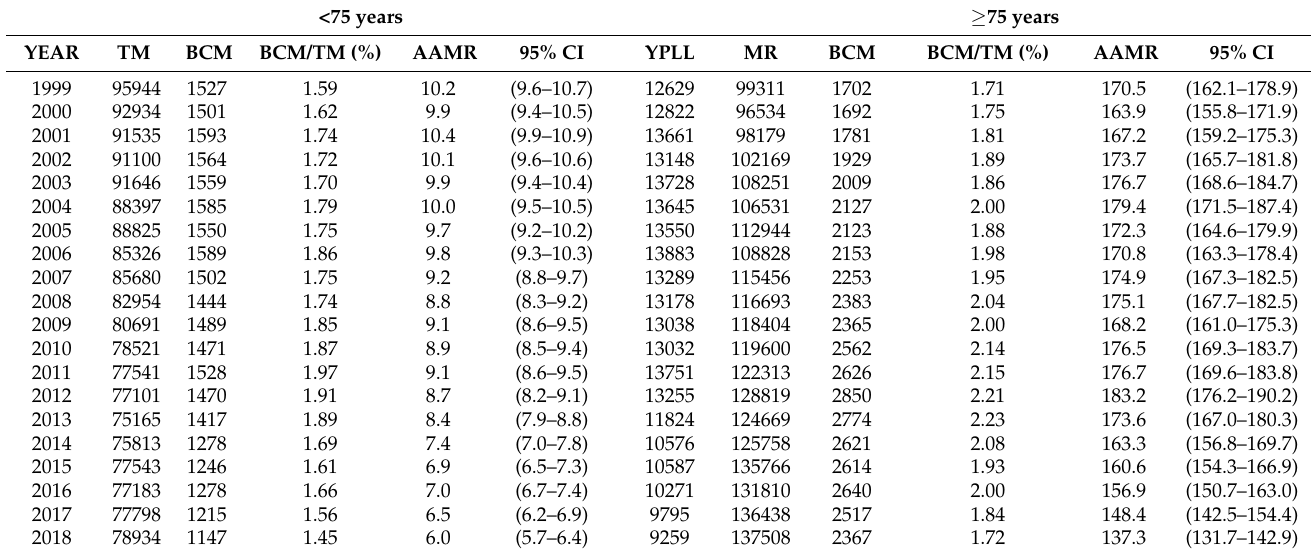
Table 1. Total mortality, mortality due to BC, proportional mortality, AAMRs related to BC per 100,000 inhabitants and YPLL by age group in men in Spain during the period 1999–2018. TM: total mortality; BCM: bladder cancer mortality; AAMR: age-adjusted mortality rate per 100,000 inhabitants (direct method, European standard population of 2013); 95% CI: 95% Confidence Interval; YPLL: years of potential life lost.